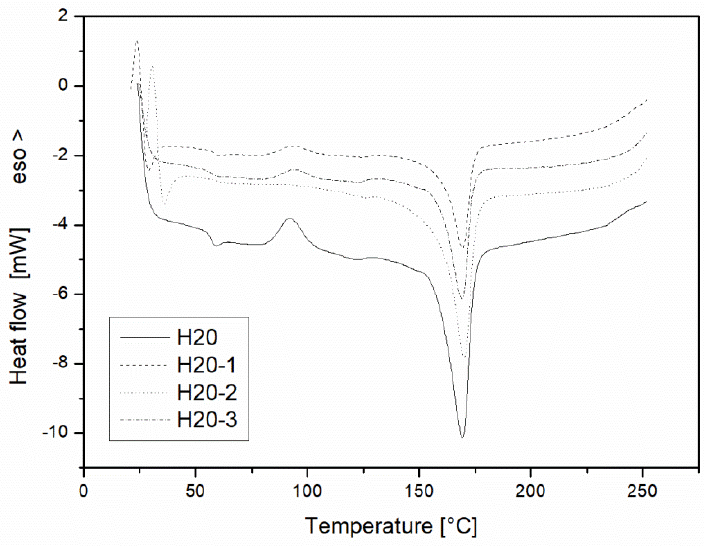
Figure 15. Differential Scanning Calorimetry of the H20 blends as a function of the recycling cycle.